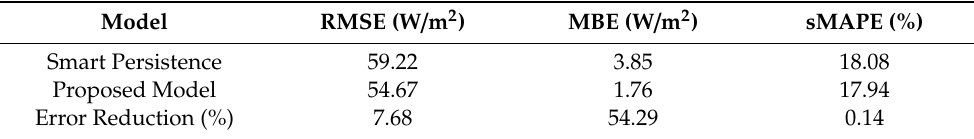
Table 7. Comparison of proposed and smart persistence models based on test data.